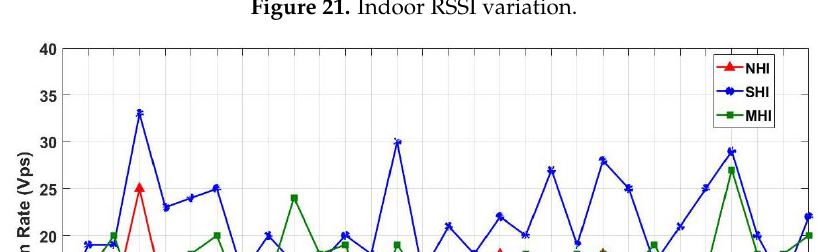
Figure 21. Indoor RSSI variation.